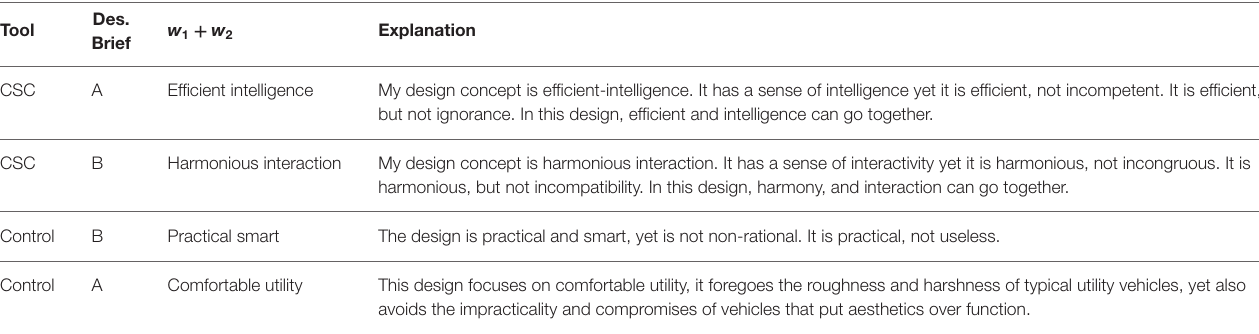
TABLE 6 | Examples of DCPs generated by participants per tools. Des. Tool